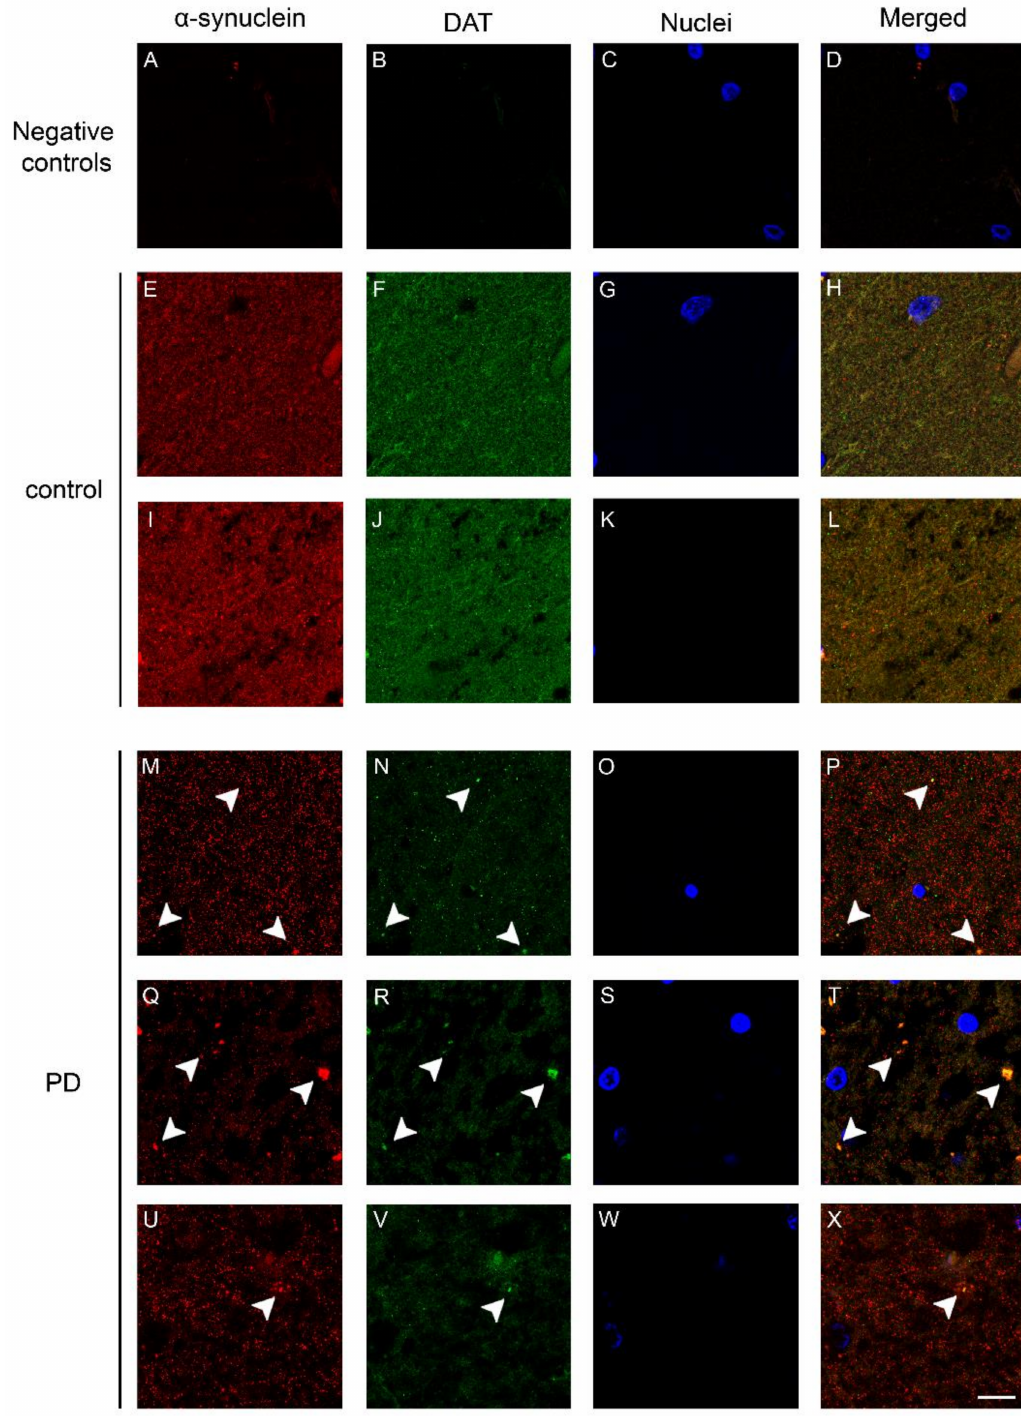
Figure 2. Double immunolabeling showing the DAT and α -synuclein in the caudate putamen of PD patients and control subjects. ( A – D ) Representative images showing negative controls performed by incubating slides with the secondary antibodies used for labeling either the DAT or α -synuclein only; ( E – X ) Panels show the confocal images of the DAT and α -synuclein fluorescent immunolabeling in the caudate putamen of patients affected by PD ( M – X ) and age-matched controls (control) ( E – L ). Please note the decrease of the widespread dot-like DAT immunolabeling in the PD samples that showed an accumulation of the protein in co-localization with α -synuclein in big clumps ( M , N , P , Q , R , T , U , V , X , arrowheads). Scale bar: 20 µ